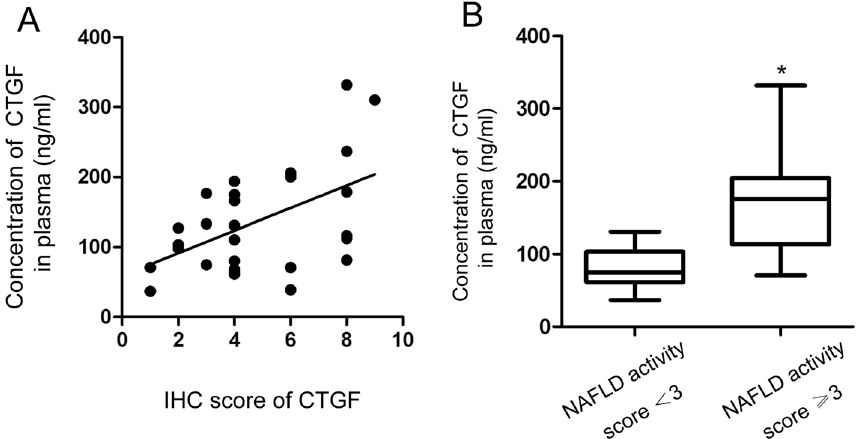
Figure 6. Correlation between CTGF expression and NAFLD activity in humans. ( A ) Correlation between systemic CTGF levels and semi-quantitative immunoreactivity scores of intrahepatic CTGF in cohort 2 (n = 27). ( B ) Systemic CTGF levels was higher in moderate and high NAFLD activity group (NAFLD activity score ≥ 3, n = 16) compared with no or no or low NAFLD activity group (NAFLD activity score ˂ 3, n = 11) (* P <